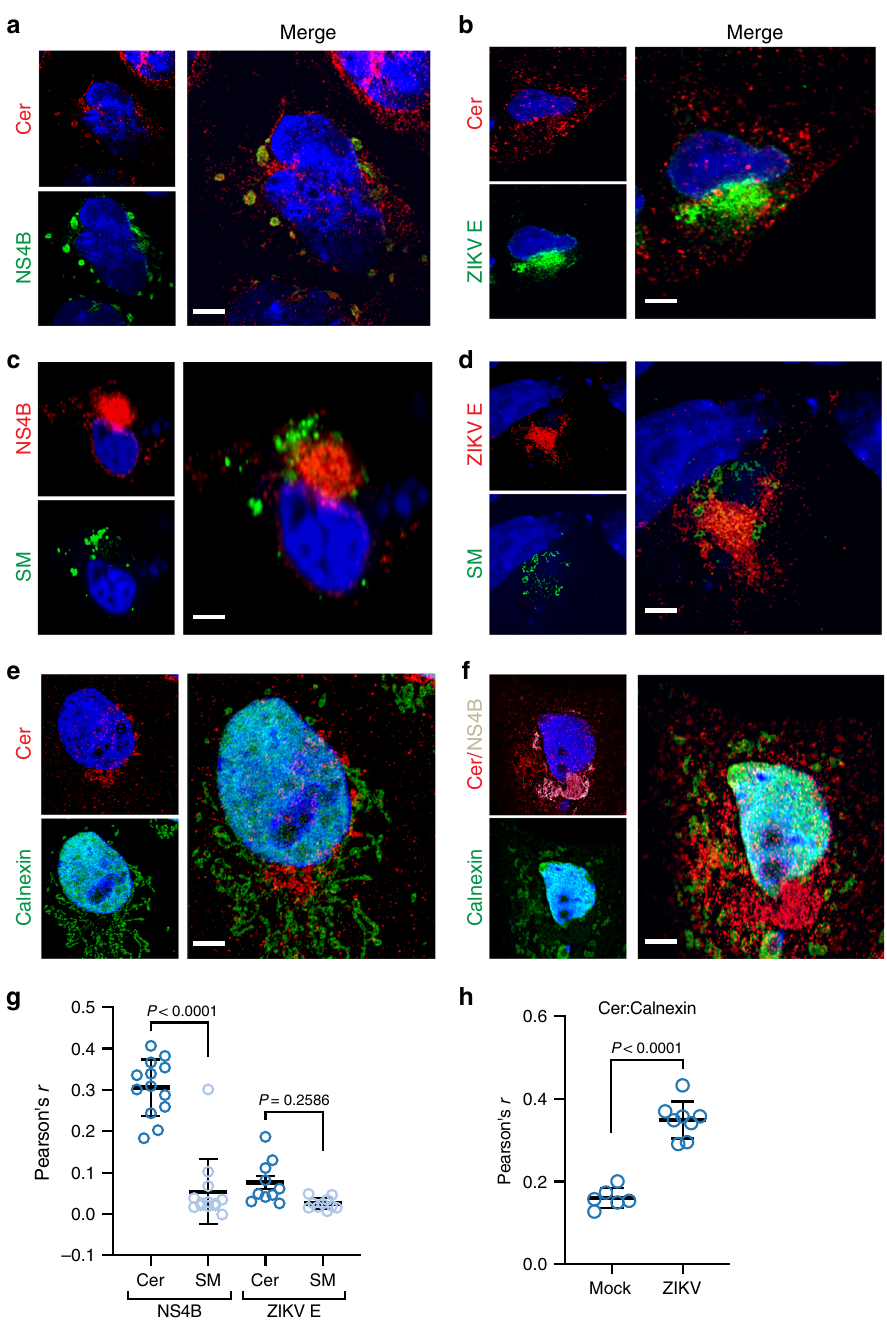
Fig. 7 Ceramide redistributes to ZIKV replication sites. Huh7 cells were infected with ZIKV (MOI = 10). At 24 hpi, mock and infected cells were fi xed, co- stained with the indicated antibodies, and visualized with Airyscan superresolution light microscopy. All images are representative of four independent experiments. a , b Cells were co-stained with antibodies against ceramide and ZIKV replication marker NS4B ( a ) or E protein ( b ). c , d Huh7 cells were transfected with SM-Eqt-GFP immediately following infection, then fi xed, stained with antibodies against ceramide and NS4B ( c ) or E protein ( d ), and visualized as before. e , f Mock ( e ) and infected ( f ) cells were stained with antibodies against ceramide, NS4B, and the ER marker calnexin. g , h Pearson ’ s correlation coef fi cient was calculated for the indicated pairs of signals ( n = 10 cells per condition pooled from four independent experiments; each dot represents r from a single fi eld of view containing one or more cells). Thick central bar, mean; upper and lower bars, SD. Unpaired two-tailed Student ’ s t test. a – f Scale bar, 10 μ